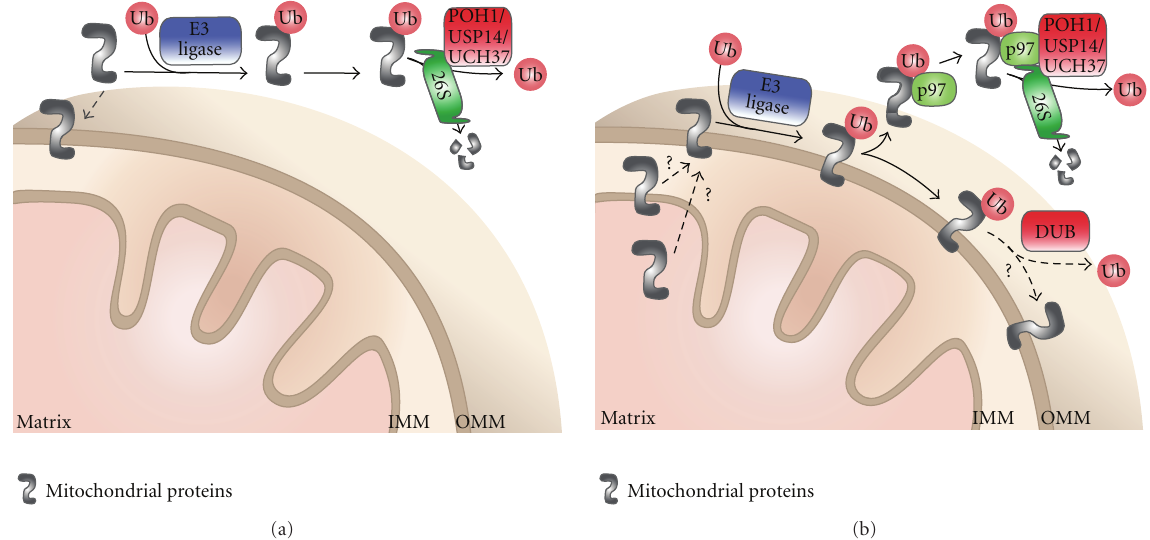
Figure 1: A model of UPS-mediated mitochondrial protein degradation. (a) Damaged and/or misfolded nuclear-encoded proteins that are destined for import into the mitochondria are intercepted by E3 ubiquitin ligases and labeled with K48-linked polyubiquitin chains. Subsequently, these proteins undergo degradation by the cytoplasmic 26S proteasome. Only the substrate alone is degraded, while ubiquitin is recycled by one or more of the proteasomal-specific deubiquitinating enzymes (DUBs, shown in red). (b) The turnover of proteins that are already at the mitochondria occurs via a process called mitochondria-associated degradation (MAD). Defective proteins at the OMM are polyubiquitinated by E3 ligases. These proteins are then extracted from the membrane by the AAA-ATPase p97 and delivered to the proteasome for proteolysis. Alternatively, mitochondrial-associated DUBs may rescue proteins from degradation by editing or removing the degradative ubiquitin signal. Hence, DUBs may enhance the stability of mitochondrial proteins. In addition, many lines of evidence suggest that the UPS also facilitates the degradation of non-OMM proteins. However, the mechanistic details of how proteasomal substrates within inner compartments retrotranslocate to the OMM have not yet been